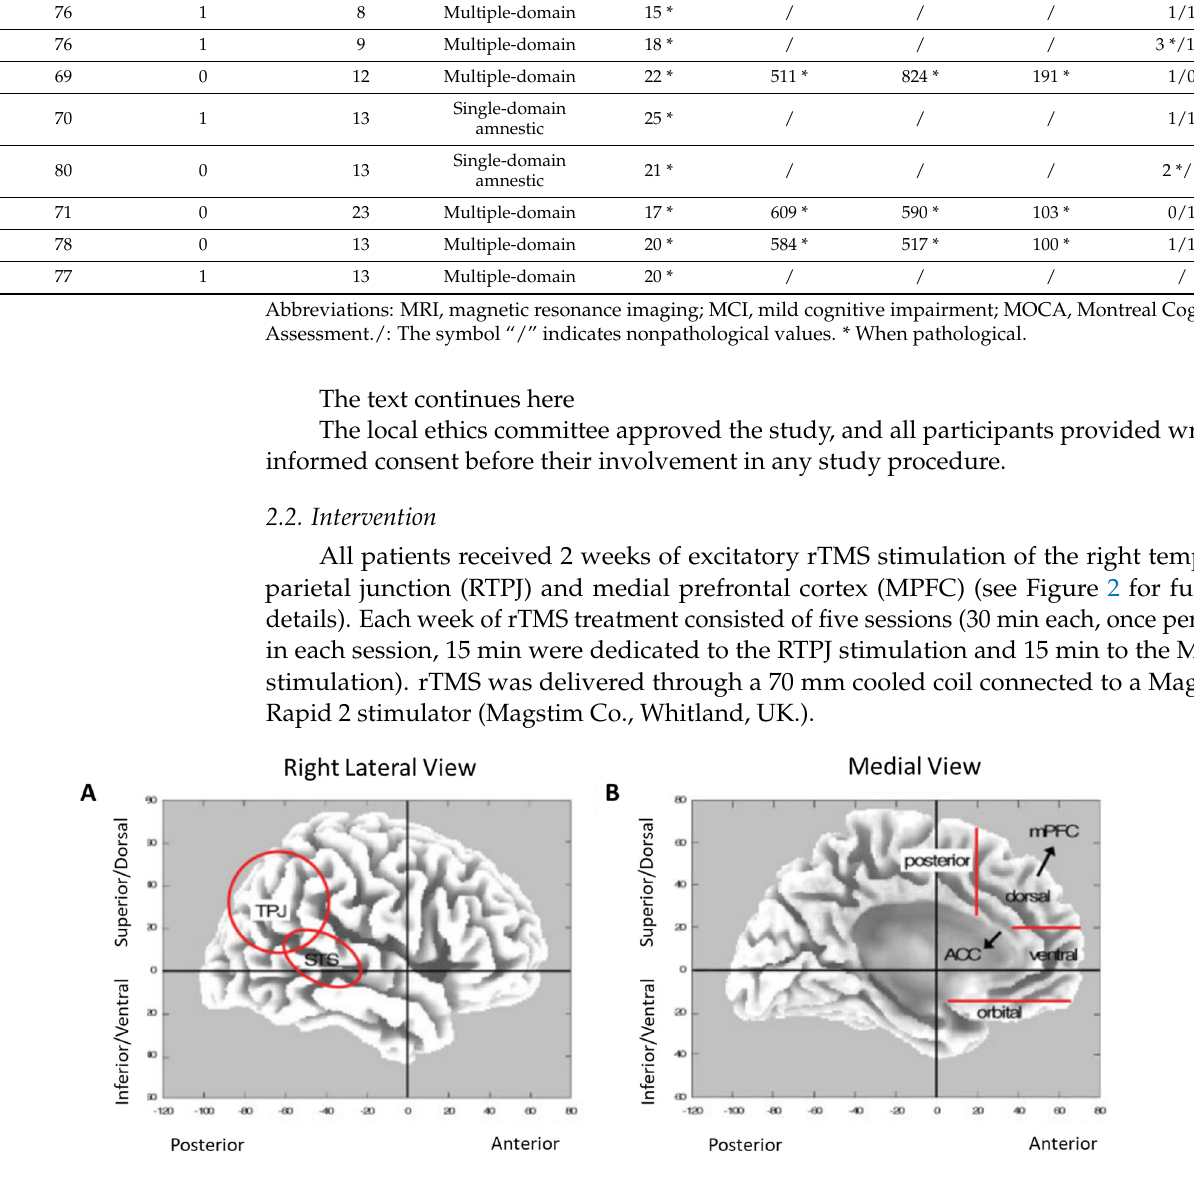
Figure 2. ( A , B ) The anatomy of the human brain and the major areas involved in social cognition, placed in x–y–z stereotactic atlas, from F. V. Overwalle, Human Brain Mapping 30:829–858 (2009).